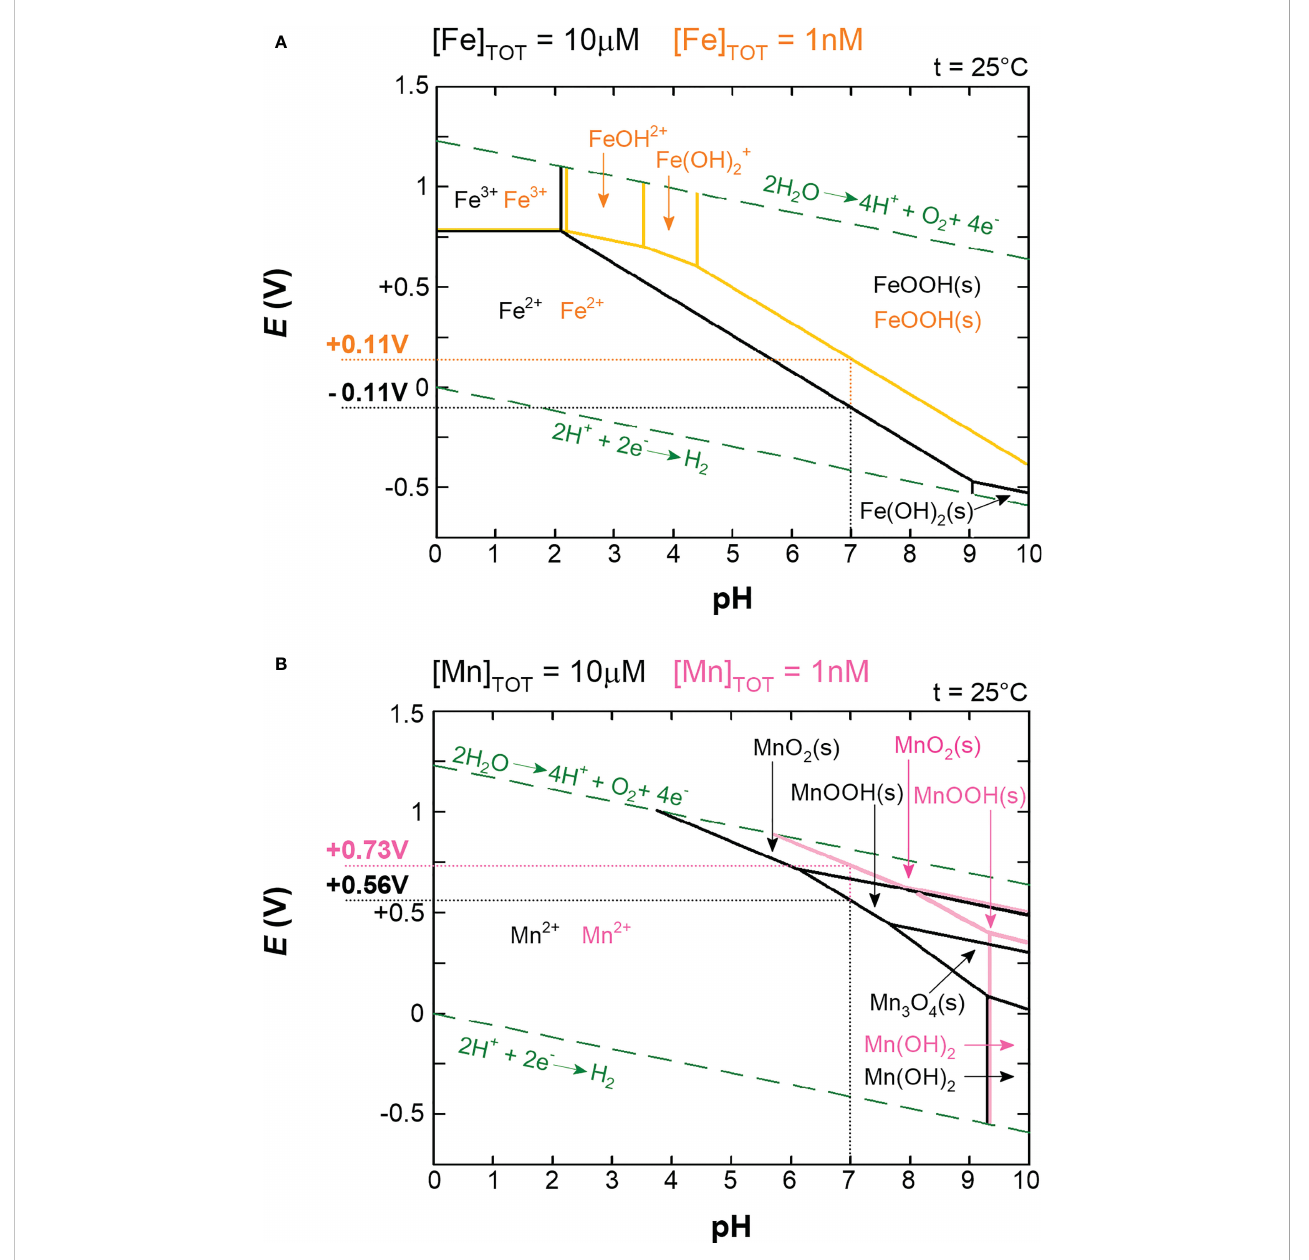
FIGURE 2 Pourbaix diagrams for iron (A) and manganese (B) . In both diagrams, precipitates (s) are probably suppressed by complexation in living cells. The green dashed lines indicate the stability of the water. The solid lines (black, orange, and pink) represent redox and acid-base reactions, and on these lines the two species are in equilibrium. The areas delineated from the equilibria indicate which oxidation state is predominant. Two concentrations are shown for each metal: 10 m M (black lines) and 1nM (orange lines for iron and pink lines for manganese). 10 m M concentration roughly corresponds to intracellular free pools in aerobically grown cells and 1nM roughly corresponds to oxygen-rich environmental conditions (Anbar, 2008; Beauchene et al., 2017). Actual redox potentials ( E ) for iron and manganese at corresponding concentrations and at pH 7 were subtracted from the graphs and are shown next to the y -axis. Note that the standard redox potentials ( E ° ’ ) are measured at standard conditions (1M concentrations of reactants and pH 7) and are related to the actual redox potentials ( E ) via the Nernst equation (Eq. 1). For simplicity, we use the term redox potential to refer to the actual redox potential ( E ) unless explicitly stated